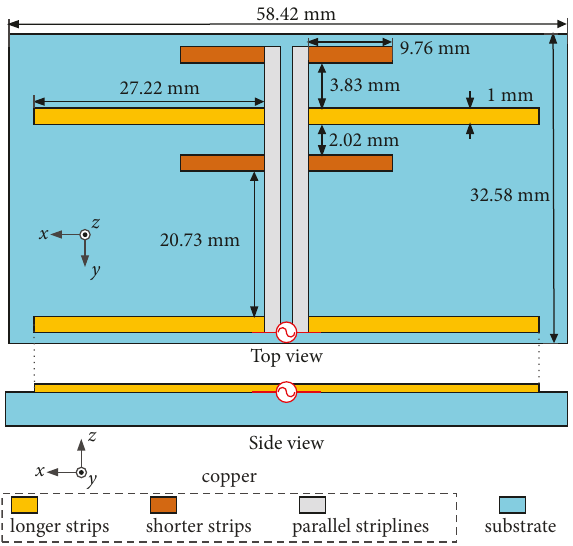
Figure 2: Configuration of the proposed dual-band directional radiation